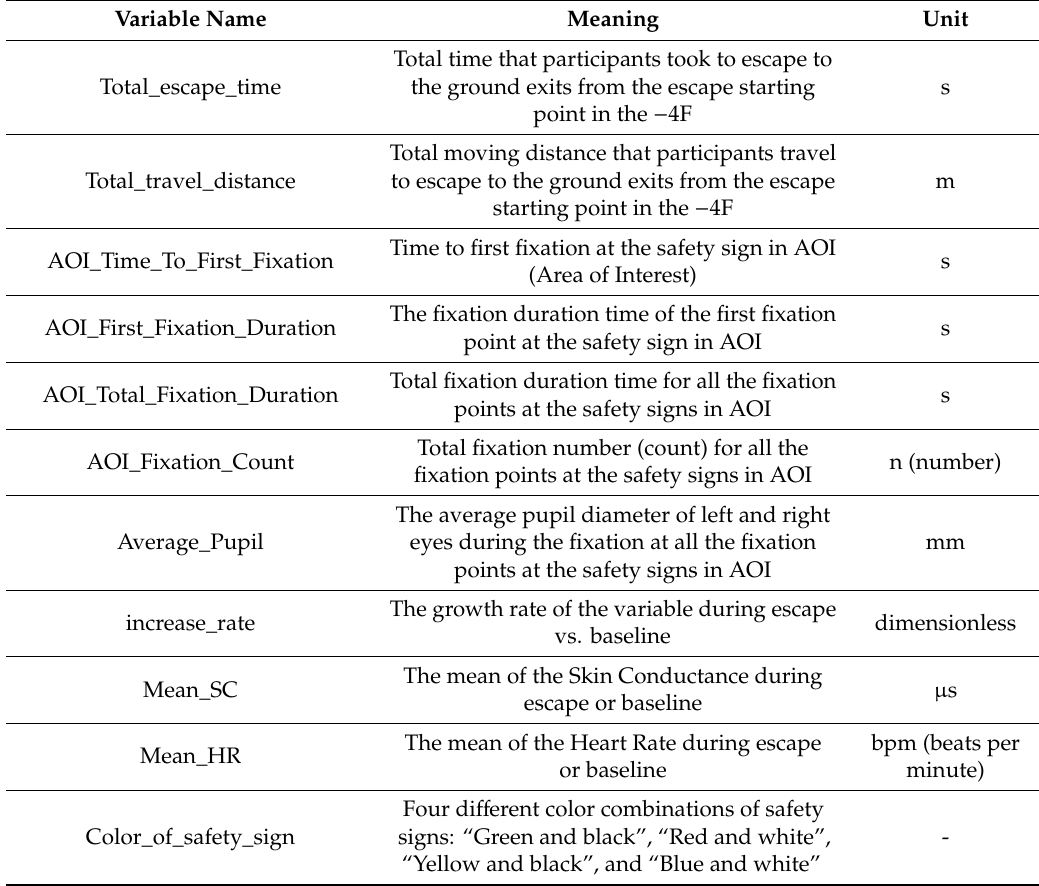
Table 3. The variables analyzed in this